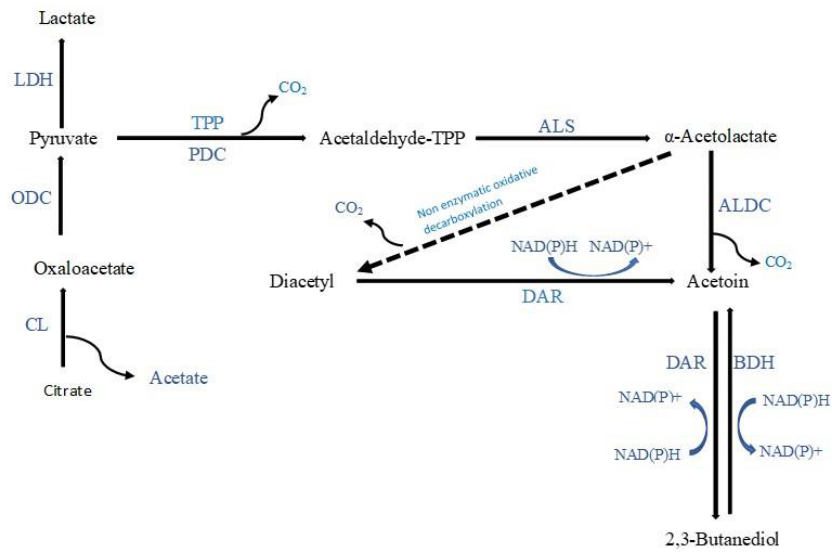
Figure 3. Citrate metabolic pathway by LAB. CL: citrate lyase, ODC: oxaloacetate decarboxylase, LDH: lactate dehydrogenase, PDC: pyruvate decarboxylase, TPP: thiamine pyrophosphate, ALS: α -acetolactate synthase, ALDC: α -acetolactate decarboxylase, DAR: diacetyl acetoin reductase, and